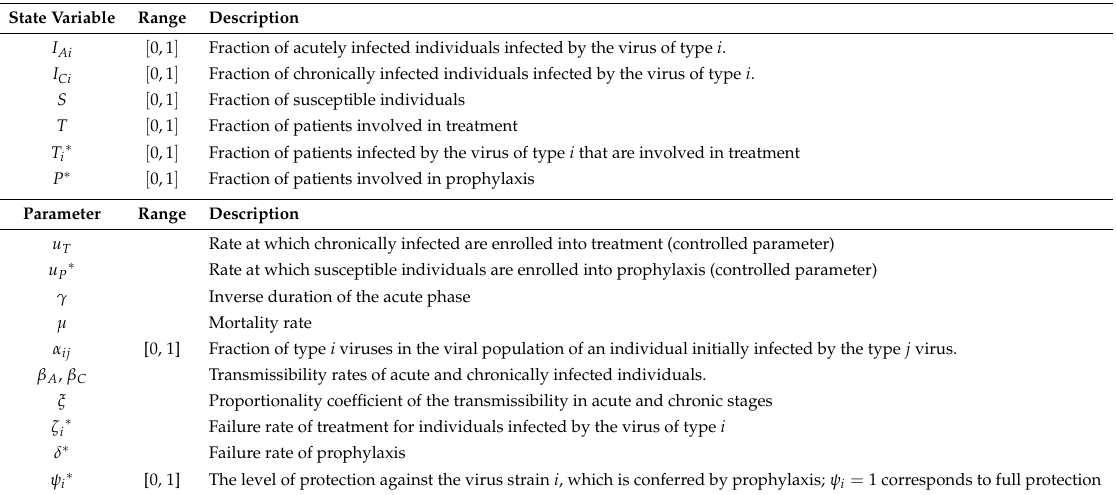
Table 1. Model parameters. Parameters indicated with an asterisk are used only in the extended model Equation